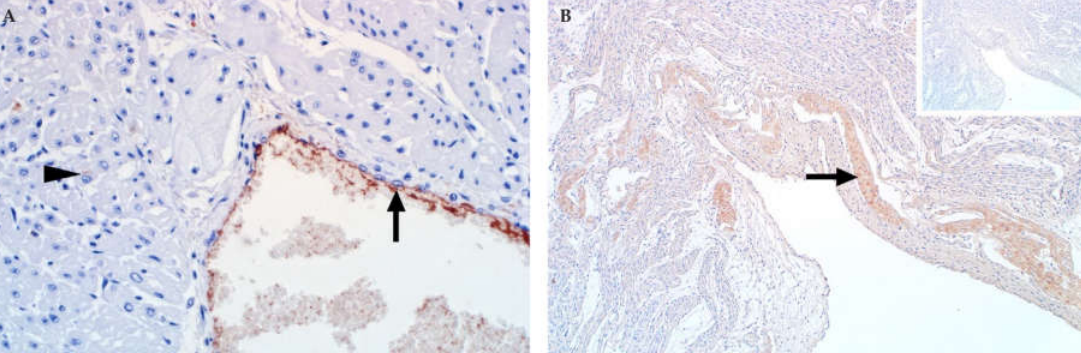
Figure 12. Heart of a RVFV-infected sheep (NovaRed IHC as detailed in Figure 5). ( A ) In this specimen from a young lamb, viral antigen is present in endothelial cells (arrow) and cardiomyocytes (arrowhead), mag 400×. ( B ) Immunolabelling is especially prominent in the Purkinje fibres (arrow), mag 100×. Inset: Negative control using a following slide from the same case (avidin-biotin-peroxidase system using mouse polyclonal anti-Wesselsbron antibody, NovaRED peroxidase substrate with haematoxylin counterstain), mag 100×.